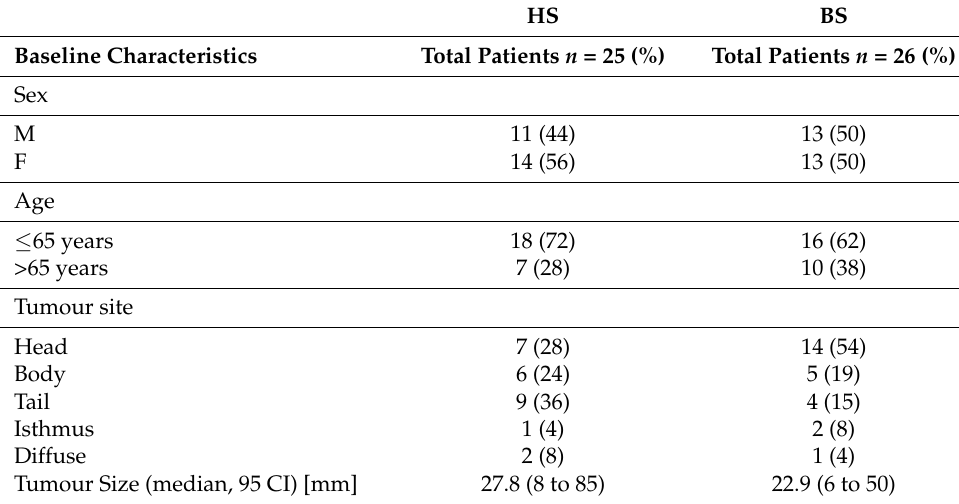
Table 1. Clinical and epidemiological patients’ data in the two cohorts, HS (histology sample) and BS (biopsy sample).